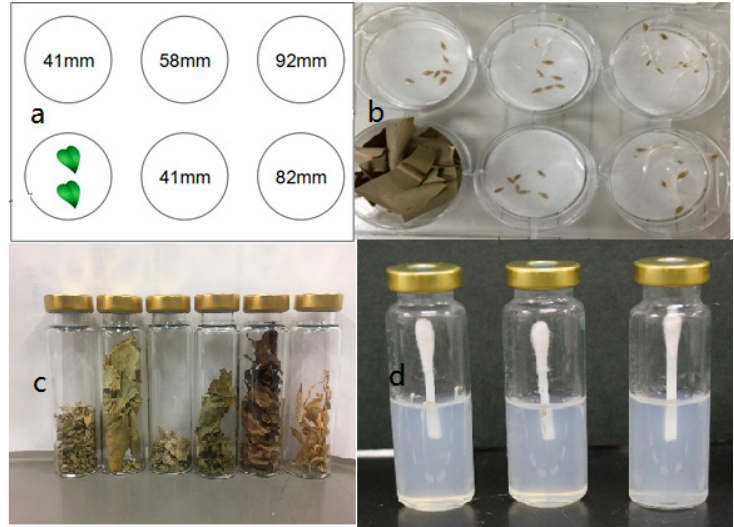
Figure 5. Testing the effect of leave volatiles from star anise on radicle and hypocotyl growth (%) of lettuce seedlings as a function of distance from plant material using the Dish Pack method ( a–b ), samples for GC-MS analysis ( c ), and cotton swab method ( d ).